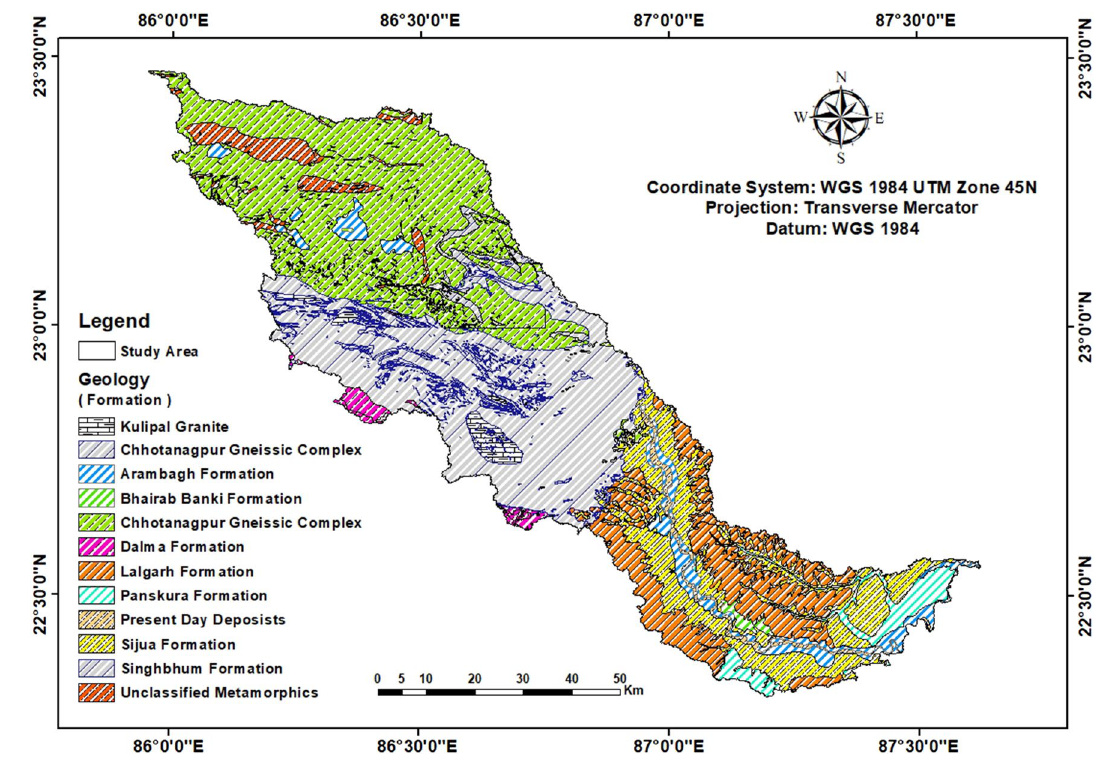
Fig. 3 Spatial map of geology showing different formations of Kangsabati River